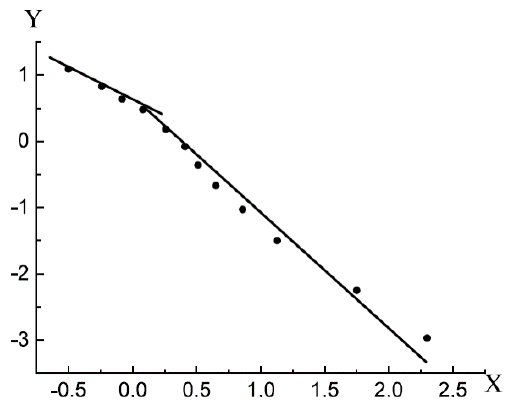
Figure 4. Adsorption isotherm of water on the lunar soil sample [13, 14] in the coordinates of Equation Equation (28); Y = ln( − ln x); X = ( ln a / a m ) (28); Y = ln(−ln x); X = (ln 𝑎/𝑎 𝑚 ) .